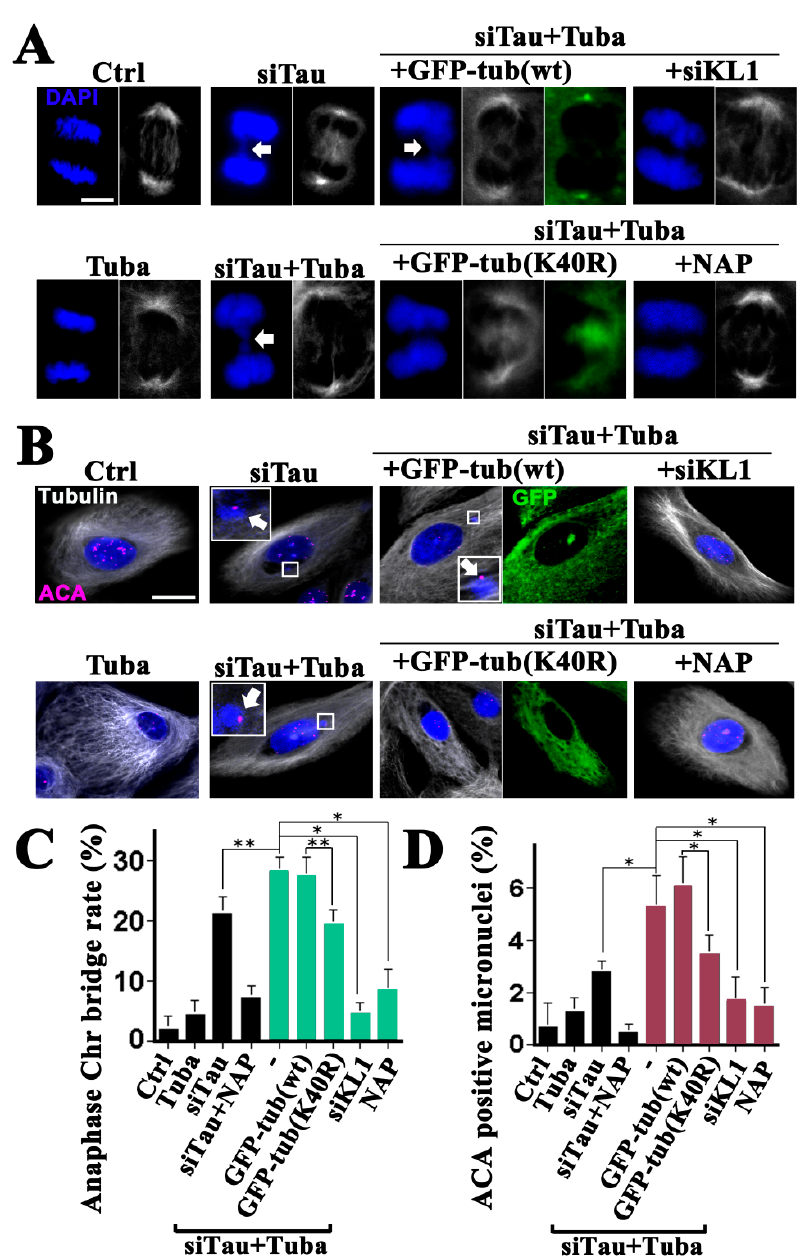
Figure 5. Tubacin treatment exacerbates tau knockdown-induced chromosome bridging and micronucleation in HMECs. HMECs were treated with tubacin (Tuba) and/or 30 nM NAP, transfected with siRNA targeting tau (siTau) with/without siRNA for KL1 (siKL1), and transfected with wild-type tubulin (GFP-tub(wt)) or unacetylatable tubulin mutant (GFP-tub(K40R)) constructs. The cells were then stained for general tubulin (Tubulin), centromeres (ACA), and DNA (DAPI). ( A ) Anaphase chromosome bridging analysis. Arrows indicate chromosome bridging. Chromosome bridging in tau-knockdown cells (siTau) was enhanced by tubacin treatment (siTau + Tuba: dual treatment). Treatment with tubacin alone did not induce chromosome bridging compared with the control cells. The dual tubacin treatment and tau knockdown-induced enhanced bridging was largely inhibited by a further KL1 knockdown (siTau + Tuba + siKL1). Under tubacin treatment and tau knockdown conditions, overexpression of wild-type tubulin did not affect enhanced bridging (siTau + Tuba + GFP-tub(wt)) whereas acetylation mutant tubulin expression inhibited this (siTau + Tuba + GFP-tub(K40R)). Further NAP treatment also recovered the normal anaphase chromosome morphology of the tubacin-treated cells under tau knockdown conditions (siTau + Tuba + NAP). Bar, 5 µm. ( B ) Interphase HMECs were assessed for ACA-positive micronucleation. Tubacin treatment alone did not induce micronucleation (Tuba). Compared with a tau knockdown by siRNA (siTau), further